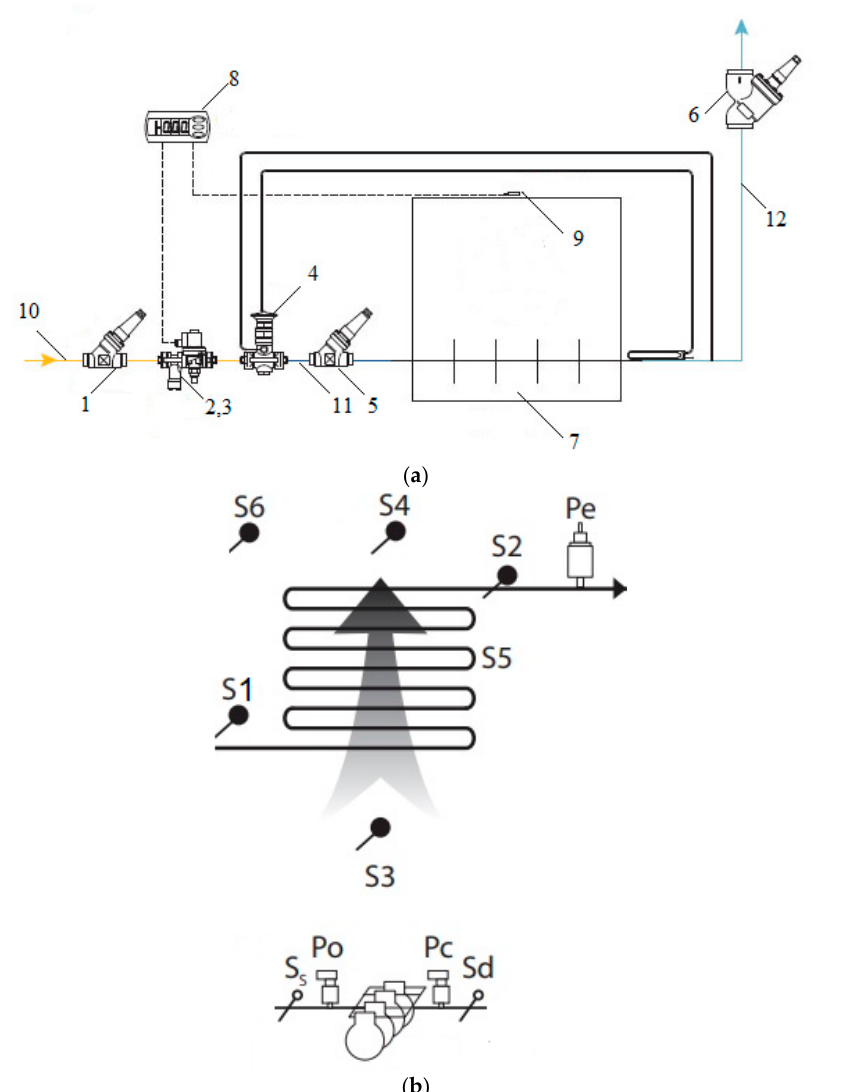
Figure 4. Experimental measurements: ( a )—Refrigerant evaporation control system R407C, ( b )—Installation diagram of the main temperature and pressure sensors on the example of an evaporator. 1—shut-off valve on the liquid refrigerant line SVA, 2—filter FA, 3—solenoid valve EVR С , 4— temperature control valve TE2, 5—shut-off valve at the evaporator inlet SVA, 6—shut-off valve on